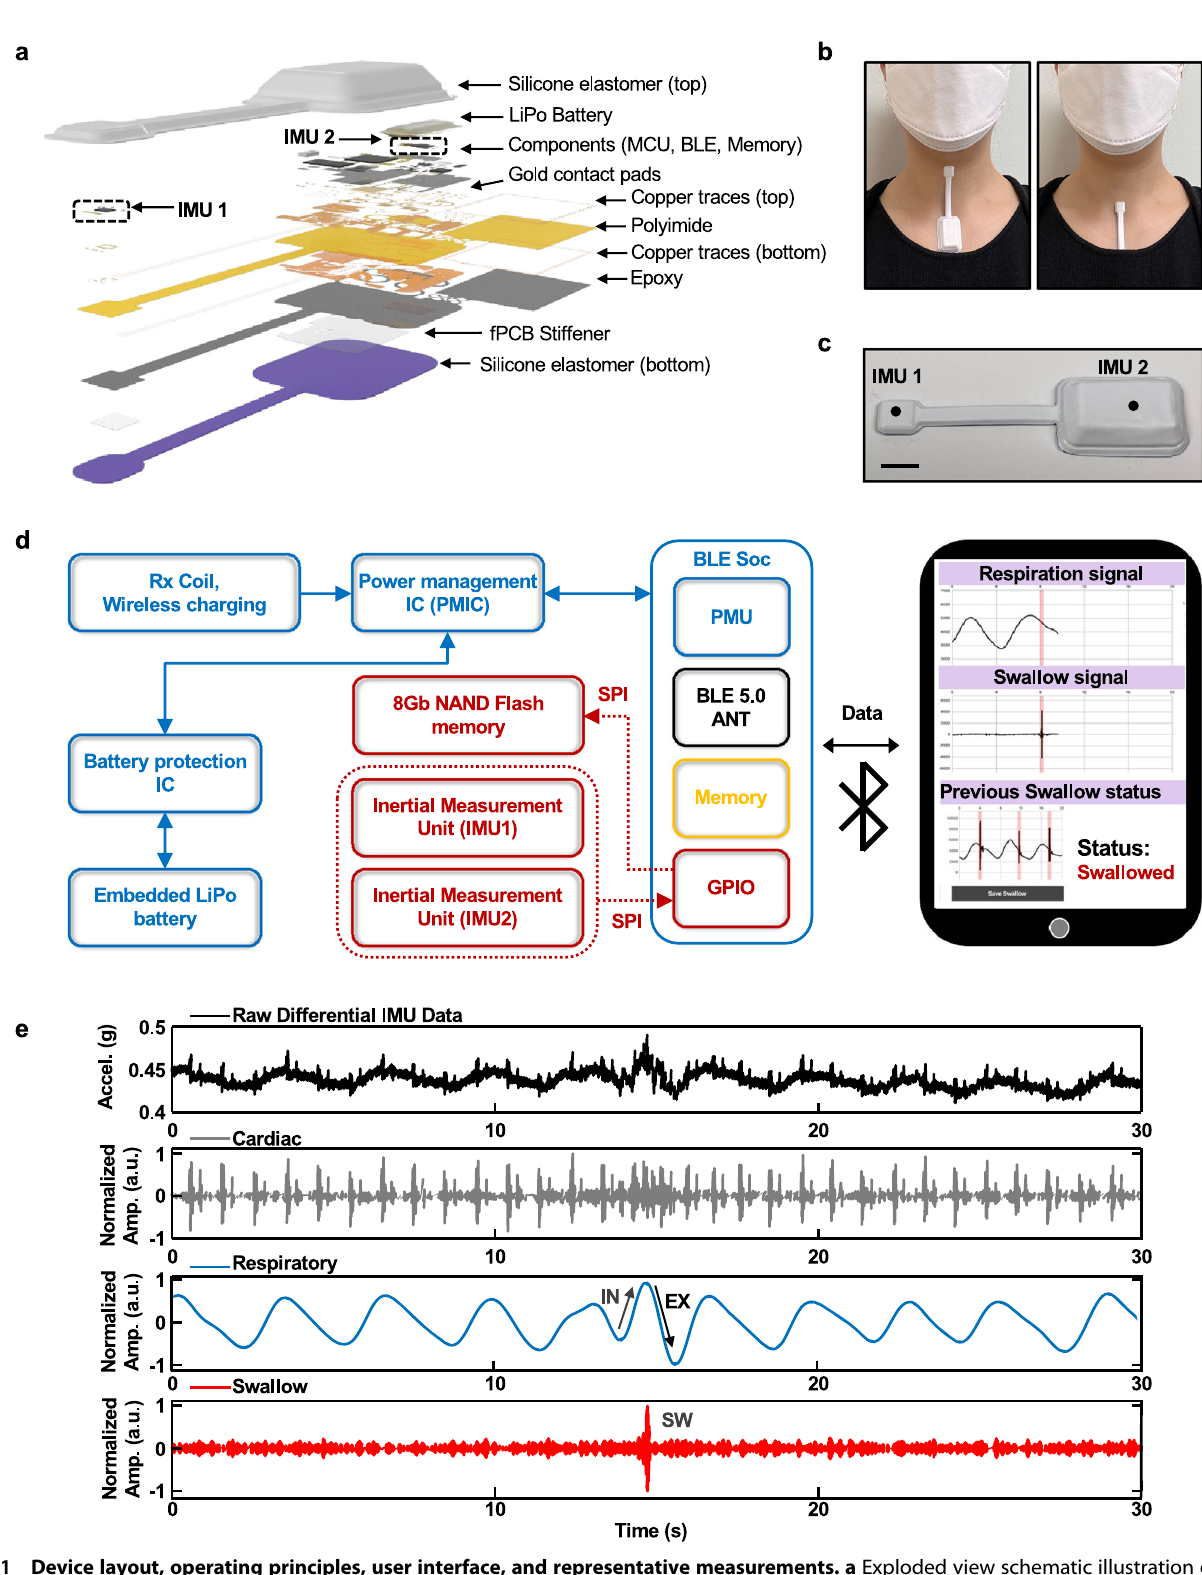
Fig. 1 Device layout, operating principles, user interface, and representative measurements. a Exploded view schematic illustration of the umbilical MA device. b Image of the device attached on the LP(IMU1)/SN(IMU2) (left) and SN(IMU1)/SM(IMU2) (right) to capture respiratory activity and swallowing events. c Image of a device with a scale bar and illustration of the locations of IMU1 and IMU2 (scale bar = 1 cm). d System block diagram of device operation and illustration of a graphical user interface with real-time data analytics. e Representative differential data from IMU1/IMU2. Graphs from top to bottom show data: unprocessed; bandpass fi ltered between 15 and 60 Hz to highlight features associated with cardiac cycles; bandpass fi ltered between 0.1 and 0.8 Hz to highlight respiratory cycles; and high pass fi ltered at 90 Hz to highlight features related to